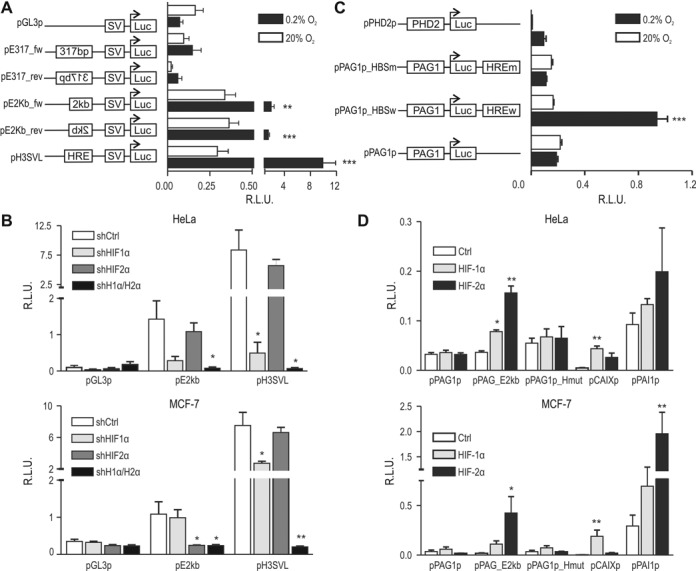
Hypoxic cis-activation of reporter genes by the −82 kb PAG1 HRE. (A) A 317 bp or a 2 kb fragment, both including the −82 kb PAG1 HRE, was used to enhance expression of an SV40 promoter-driven firefly luciferase reporter gene vector (pGL3p). pH3SVL, containing three HREs with tandem HBSs derived from the transferrin gene, was used as a positive control. Following transient co-transfection, HeLa cells were exposed to 20% O2 or 0.2% O2 for 24 h. Results are displayed as ratios of firefly to SV40 promoter-driven Renilla luciferase activities in relative light units (R.L.U.) from three independent experiments performed in triplicates, error bars correspond to the SEM. Statistical analyses were performed with unpaired Student's t-tests (**P < 0.01; ***P < 0.001). (B) HeLa and MCF-7 cells, stably transfected with shCtrl, shHIF-1α and/or shHIF-2α, were additionally transiently transfected with the indicated reporter genes. Statistical analyses were performed with one-way ANOVA and Dunnet's correction for multiple comparisons (*P < 0.05; **P < 0.01). (C) The 2 kb HRE fragment, containing the wild-type (HBSw) or a mutant HBS (HREm), was used to enhance expression of a PAG1 promoter-driven firefly luciferase reporter gene (pPAG1p). A PHD2 promoter-driven luciferase vector served as positive control. Statistical analyses were performed with unpaired Student's t-test (***P < 0.001). (D) HeLa and MCF-7 cells were transiently co-transfected with the indicated reporter gene vectors together with empty, HIF-1α and HIF-2α overexpression vectors. The CA9 and PAI1 promoter-driven luciferase vectors served as HIF-1α and HIF-2α, respectively, isoform-specific controls. Statistical analyses were performed with one-way ANOVA and Dunnet's correction for multiple comparisons (*P < 0.05; **P < 0.01). (B–D) Exposure to hypoxia and determination of reporter gene activity was performed as in (A).